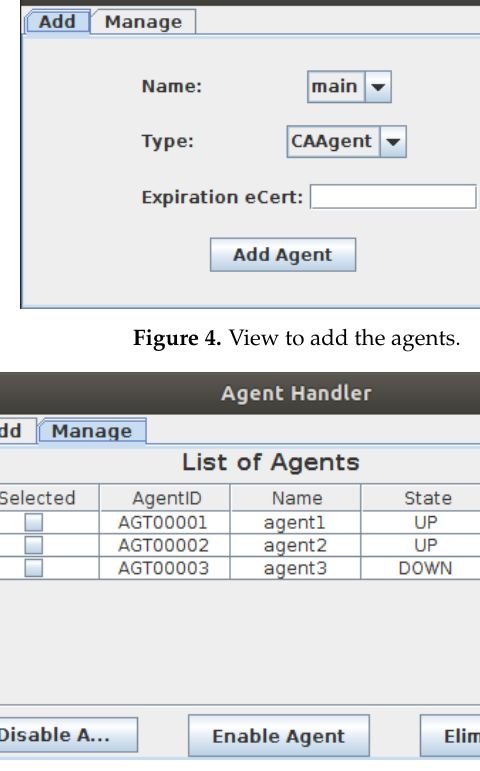
Figure 5. View to manage the agents.